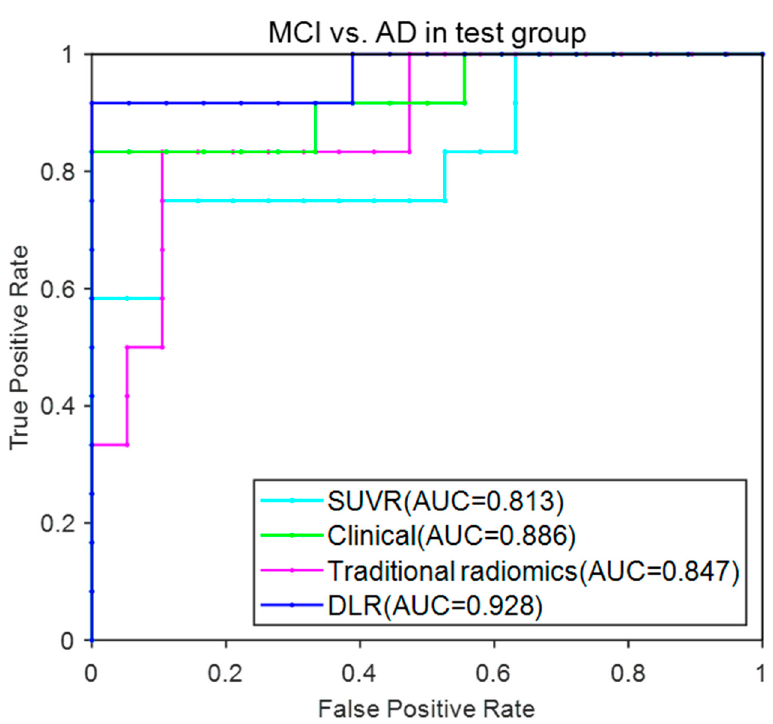
Figure 6. ROC curves for the four models in MCI vs. AD.